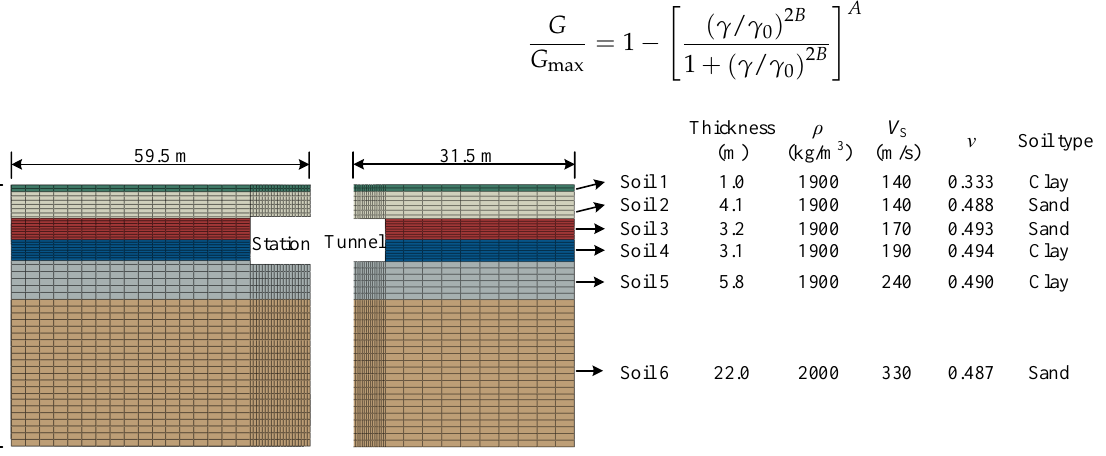
( b ) Figure 10. Stiffness parameters of soil: ( a ) Shear modulus ratio-shear strain curve of sand; ( b ) Shear modulus ratio-shear strain curve of clay. The pushover analysis is a pseudo-static method with no damping being involved in the numerical calculation. The shear modulus ratio-shear strain curves for different types of soils are given in Figure 10. The 3D finite element models of the original Daikai station, the original subway tunnel and the new Daikai station are shown in Figure 11. It is diffi- cult to strictly restore the reinforcement of the actual Daikai station and the tunnel during the model establishment, so the side walls and the slabs are modeled according to Table 1, making it as close to the actual situation as possible. In the finite element model of the central column, the material parameters of the reinforcement and concrete are identical to the previous Section 4.2.